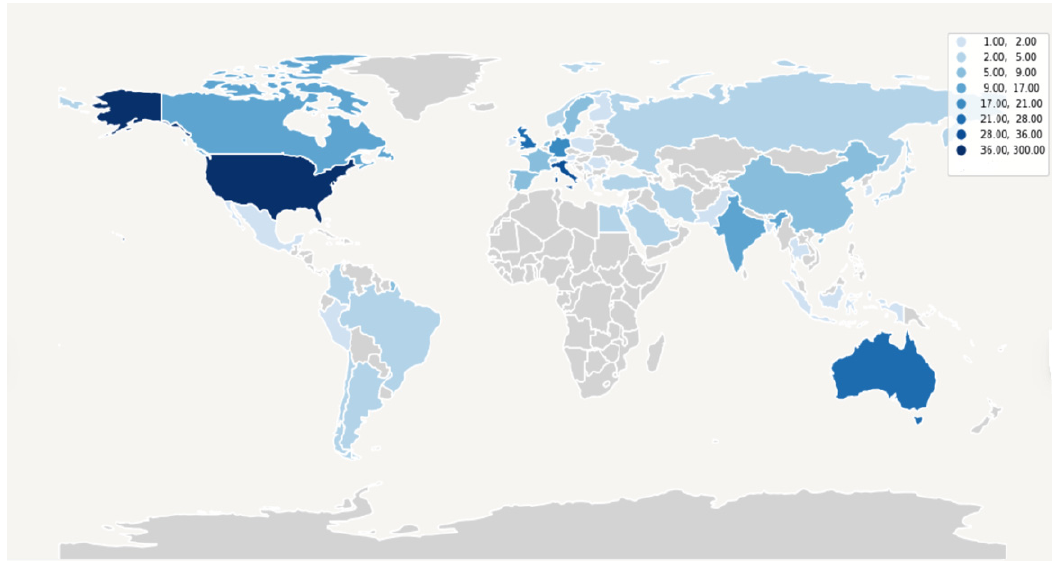
Figure 2. Prevalence of records published in different countries.